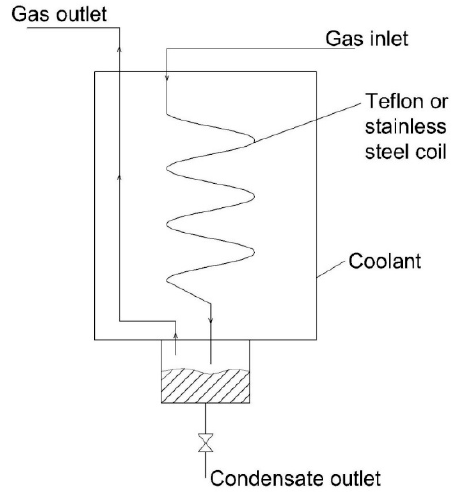
Figure 1. Typical structure of a refrigerated moisture removal device [1].